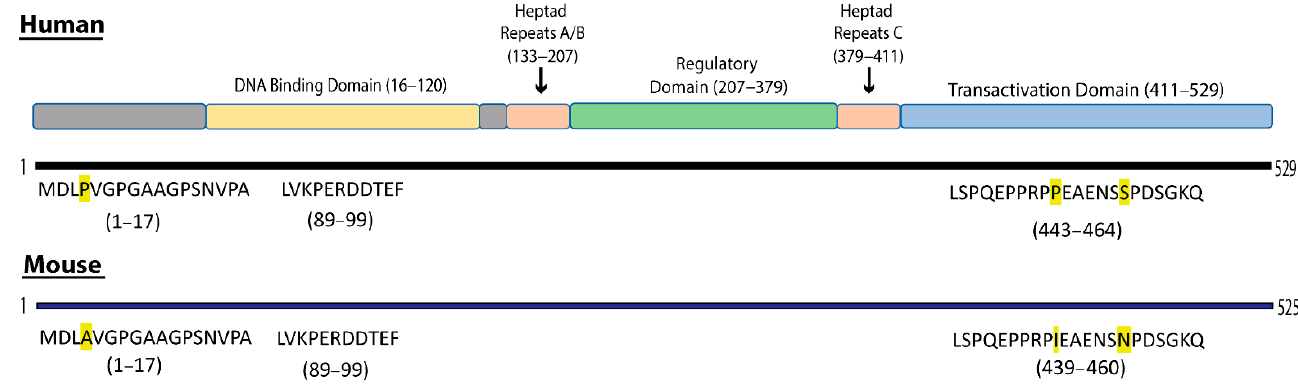
regulatory domain and the transactivation domain [33]. HuHSF1 contains 529 amino acids (aa) in the sequence and mouse HSF1 (MuHSF1) contains 525aa. Three locations in the human sequence were selected for further testing: aa1–17, aa89–99 and aa443–464. The orthologous sequences in MuHSF1 were also selected (aa1–17 and aa439–460). Highlighted residues